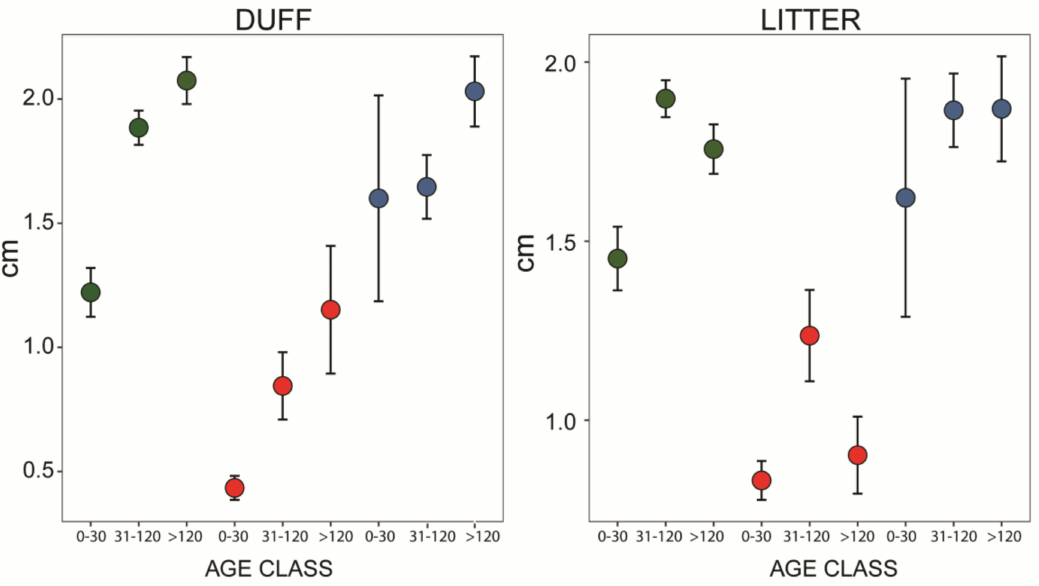
Figure 7. Mean depth (cm) of duff and litter for interior Douglas-fir stands stratified by disturbance types no major disturbance (NMD) (green dots), fire (red dots), and insects (blue dots) across stand development age classes for each disturbance